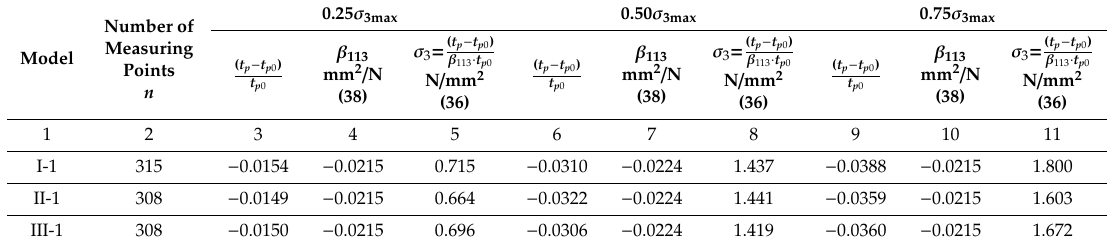
Table 5. Results from calculating normal stress in the wall using all measuring